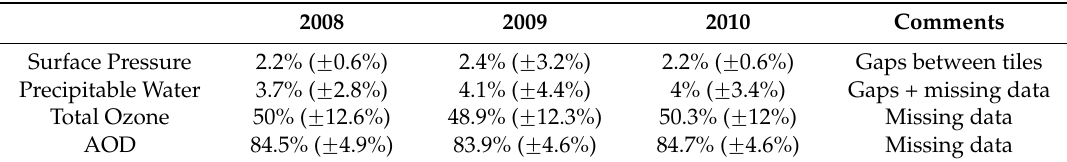
Table 5. Percentage of missing data for each of the atmospheric products used in the atmospheric transmissivity factor